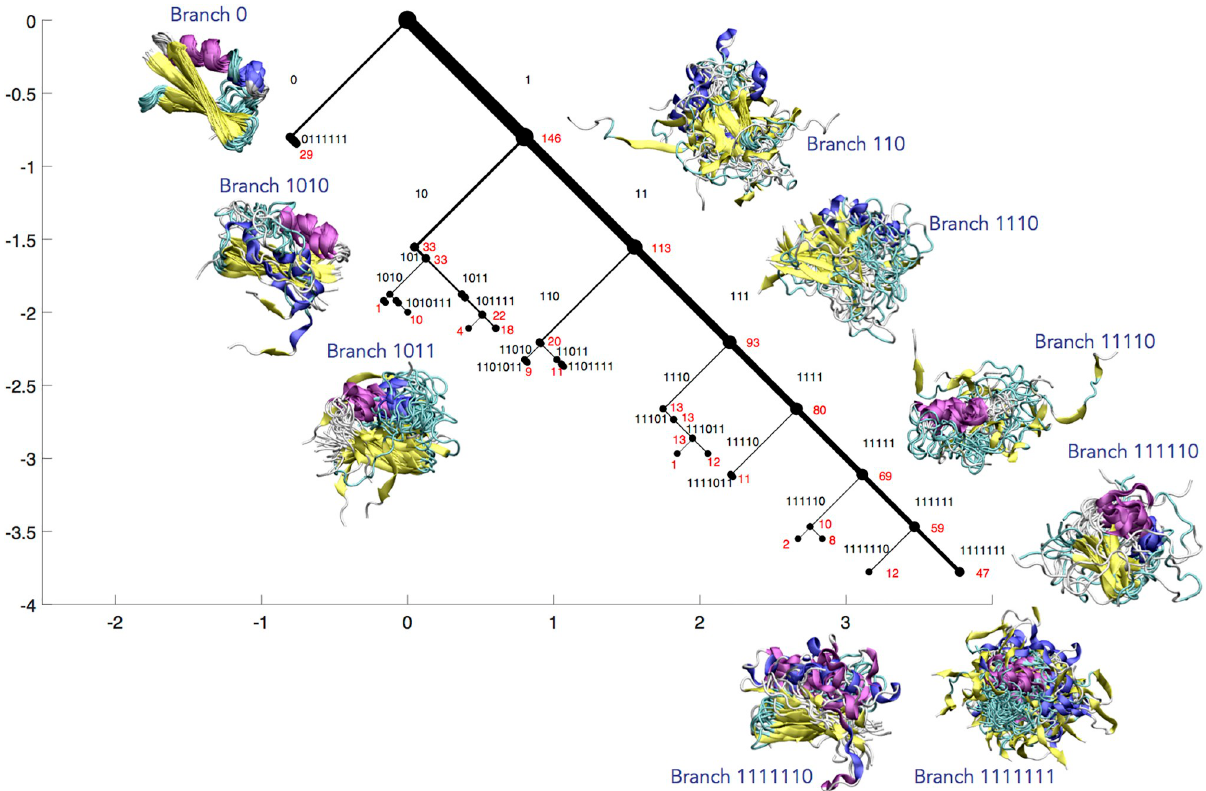
Fig 6. Atomistic protein folding simulation. The sCSC dendrogram for protein folding simulations of Protein G isolates the folded state and eight other macrostates that characterize the folding process. Each collective structure represents one sample drawn from each MSM state contained in the macrostate. The 9 macrostates contain all 175 original states, and are distinguished by consistency in secondary structure: pink regions represent α - helices, blue represents 3 10 helices, and yellow represents β -sheet regions. Branch 0, which contains the folded macrostate, is the most ordered and is separated first. Branch 1111111 represents the most disordered macrostate. The other branches represent macrostates with varying degrees of order and secondary structure elements. The width of each branch is proportional to the fraction of the states that it contains. The corresponding binary code of each branch is labeled in black text, and the number of MSM states associated with each node is labeled in red text. The horizontal and vertical axes are measured in units of the parameter z . We have visualized the first 7 eigenvectors for brevity of presentation.